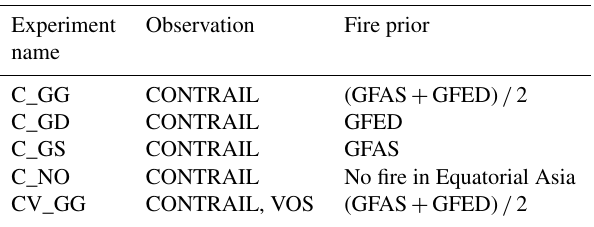
Table 2. Observation and prior fire-emission data for each inverse analysis